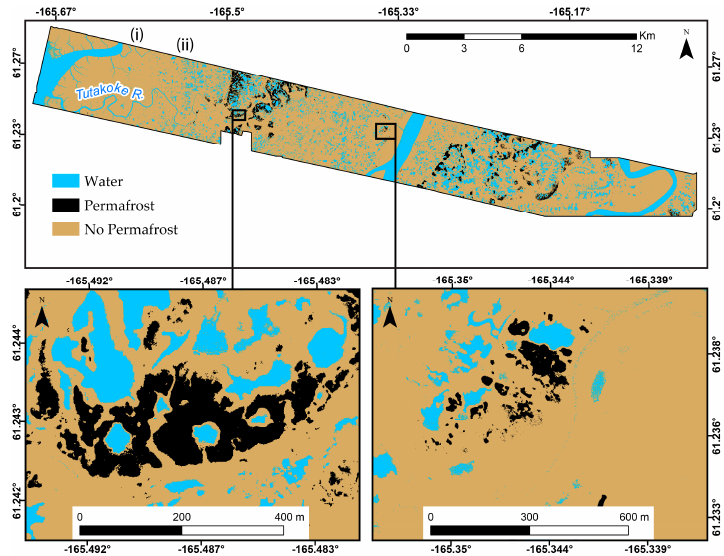
Figure 12. Permafrost map from the integrated RT classification trained with visual interpretation of the landscape (larger training set than the logistic regression). The insets show more detail in areas of relative high elevation ( left ) and areas of relative low elevation ( right ). Transitions between the mudflat and active floodplain deposit (i), and active and inactive floodplain deposits (ii) are also shown. Table 5. Model accuracy of integrated RT classification trained with visual interpretation of the landscape (larger training set than the logistic regression).